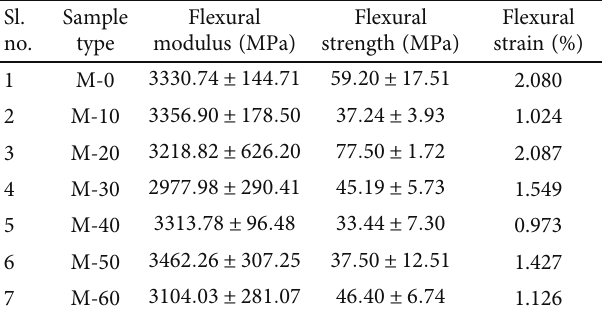
Table 4: Flexural properties of mango seed shell/epoxy composites.